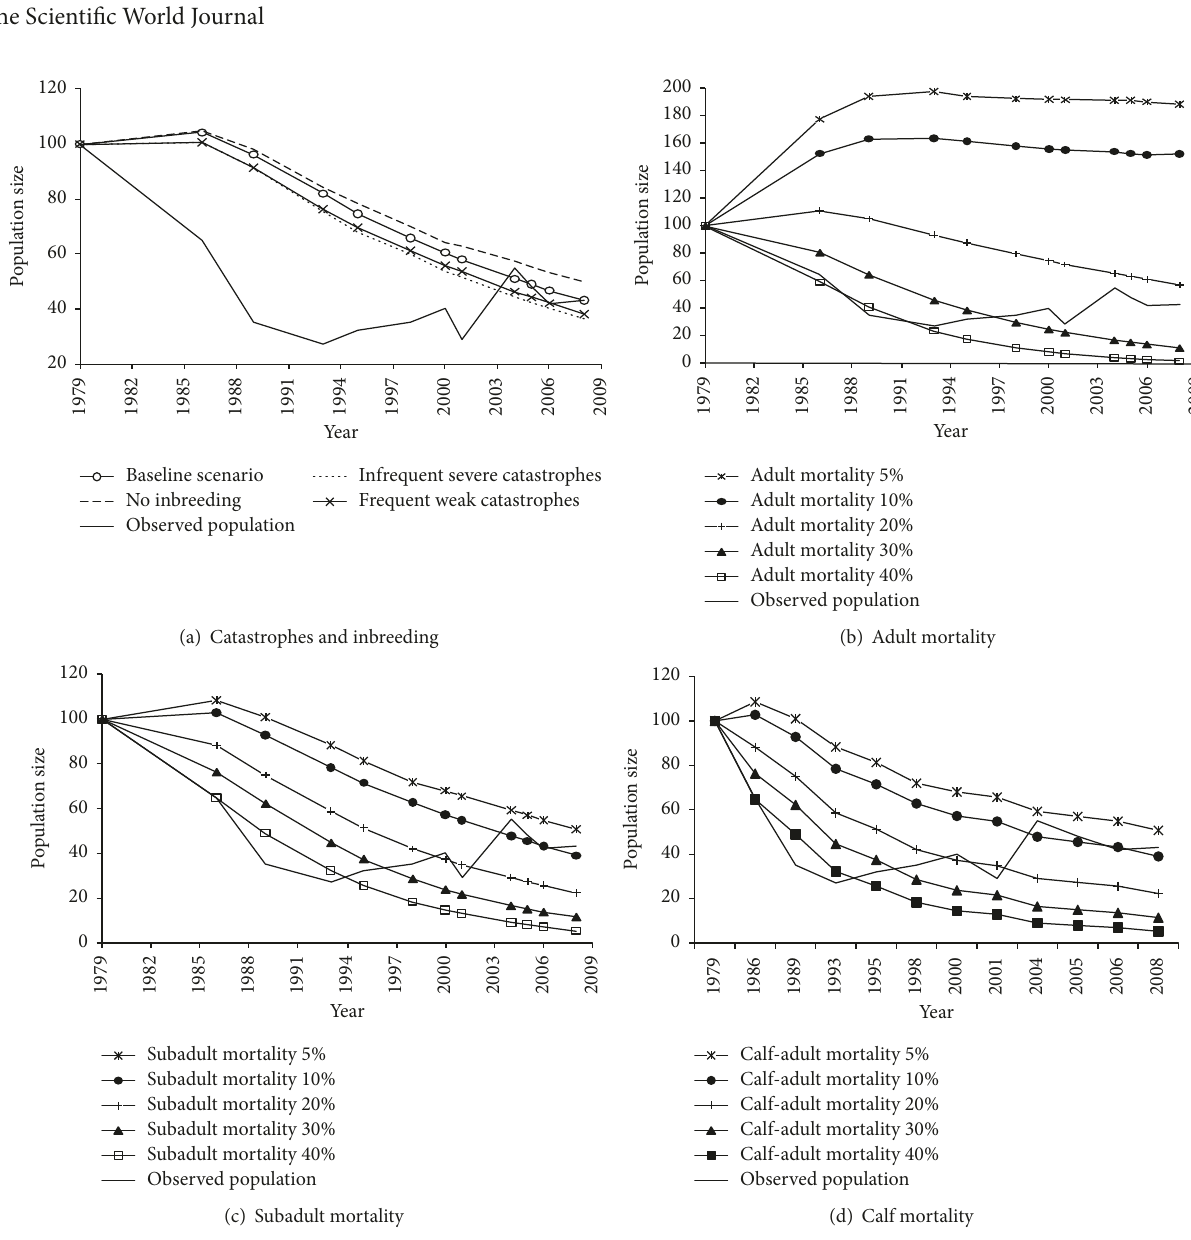
than 86% over 100 years (Table 3). Combined management interventions could raise the population growth rate to 2.3% and the persistence probability to 99.8% over 100